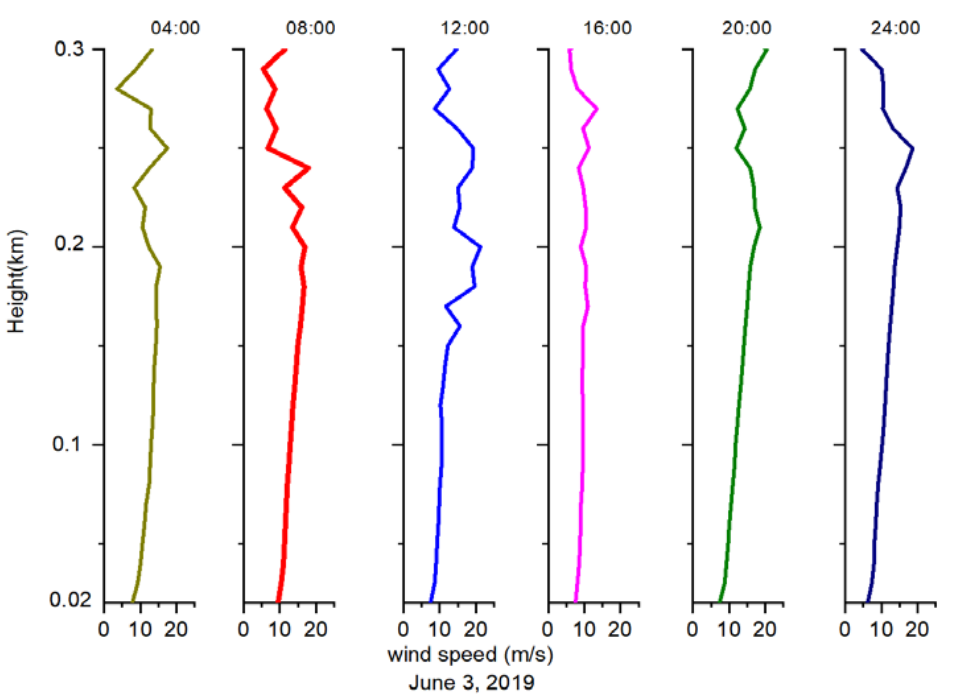
Figure 5. Wind speed profiles measured from sodar on 3 June 2019.